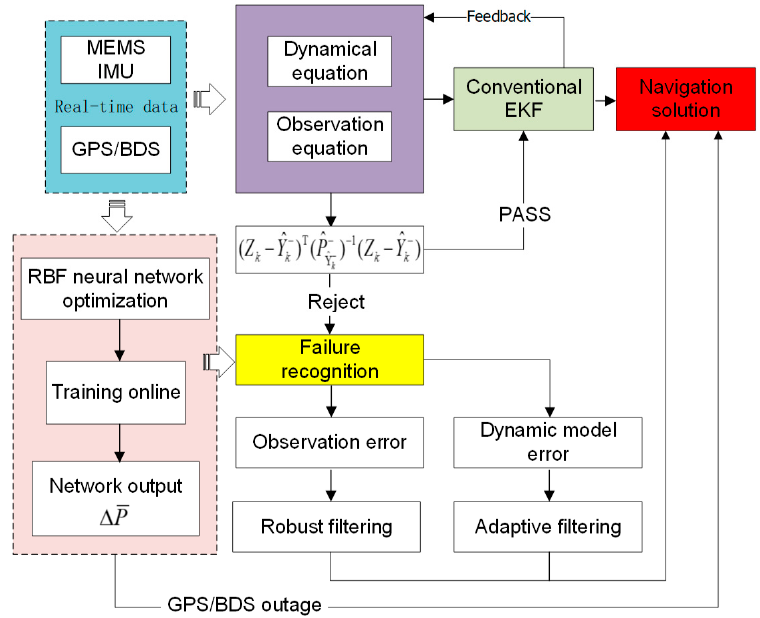
Figure 3. Technical scheme used in this research.